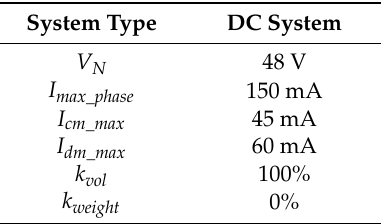
Table 2. Input data for the rule-based algorithm–case study